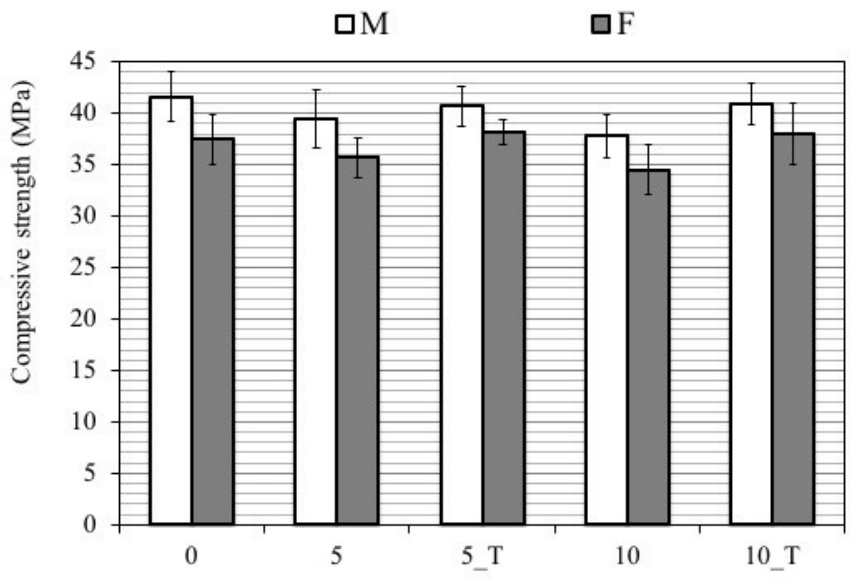
Figure 8. Compression strength of the investigated materials.